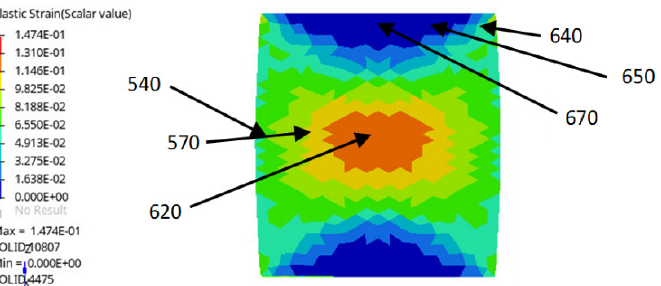
Figure 2. Radioss finite element dynamic simulation for the deformed billet. Plastic strain at the lower, middle, upper and center (axis) to exterior (surface) radius zones. Arrows indicate the average lamellar distance in nm.